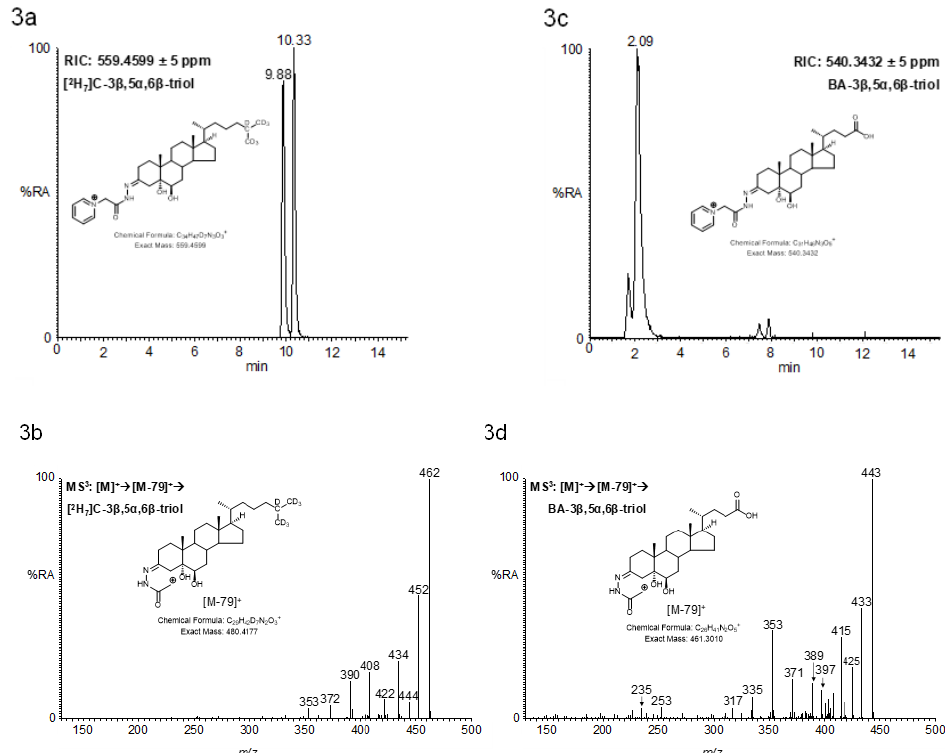
Figure 3. RICs and MS 3 ([M] + → [M-Py] + → ) spectra of cholesterol oxidase-oxidized/GP-derivatized 3 β ,5 α ,6 β -triols: ( a , b ) [25,26,26,26,27,27,27- 2 H 7 ]cholestane-3 β ,5 α ,6 β -triol ([ 2 H 7 ]C-3 β ,5 α ,6 β -triol); ( c , d ) 3 β ,5 α ,6 β -trihydroxycholanoic acid (BA-3 β ,5 α ,6 β -triol). See reference [8] for a description of